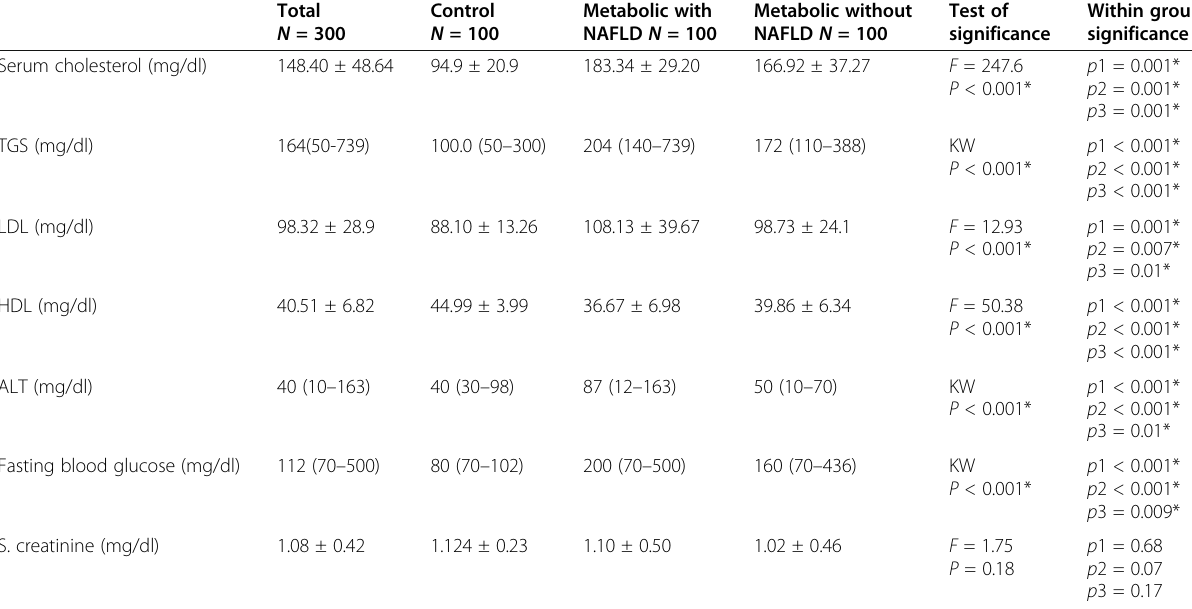
Table 3 Laboratory parameters among the 3 studied groups